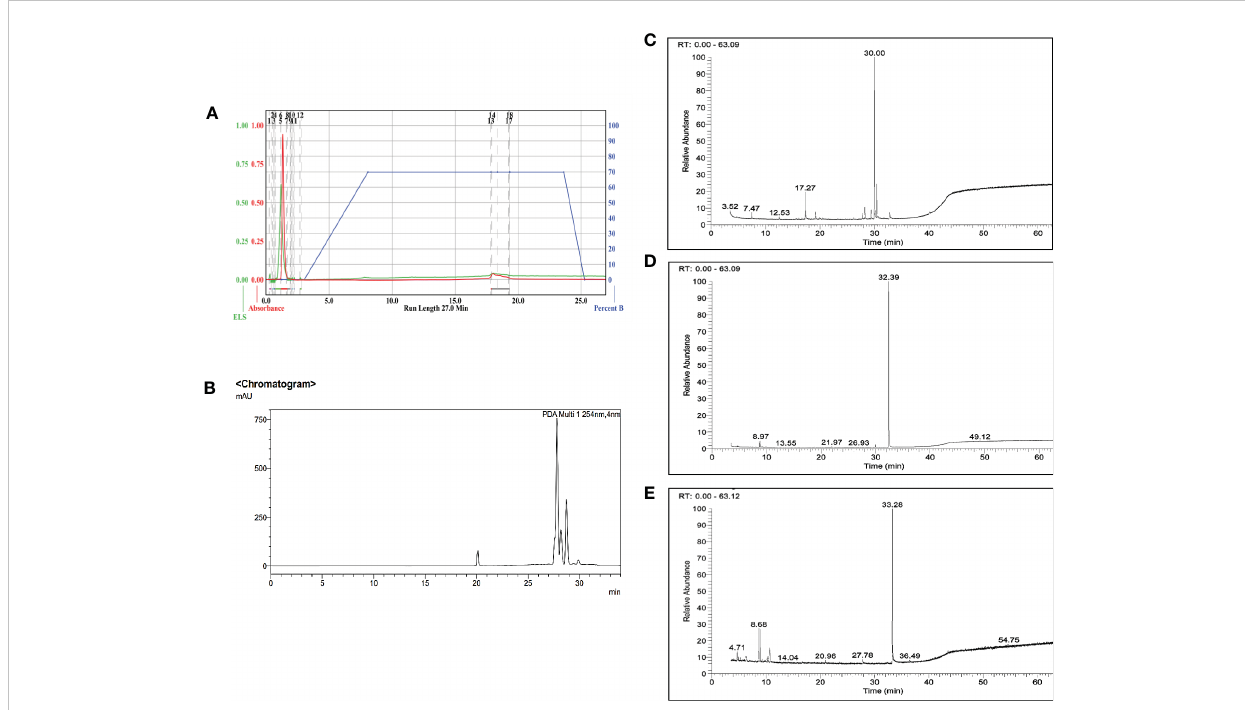
FIGURE 3 Isolation and characterization of the bioactive markers from the enriched fraction (A) . Chromatogram from Flash chromatography, (B) . Chromatogram from Semi- preparative HPLC, and (C – E) Representative GC-MS ion chromatogram of the three isolated bioactive compounds, 6-Hydroxy-4,4,7a- trimethyl-5,6,7,7a-tetrahydrobenzofuran-2(4H)-one (commonly known as loliolide), 1,2-Benzisothiazol-3(2H)-one, and Benzothiazole,2-(2- hydroxyethylthio)-